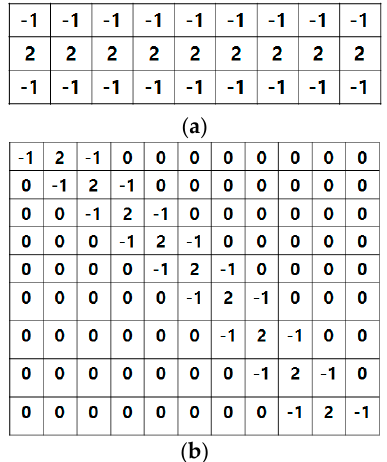
Figure 2. Filters to extract horizontal ( a ) and diagonal ( b ) lines in the image space.